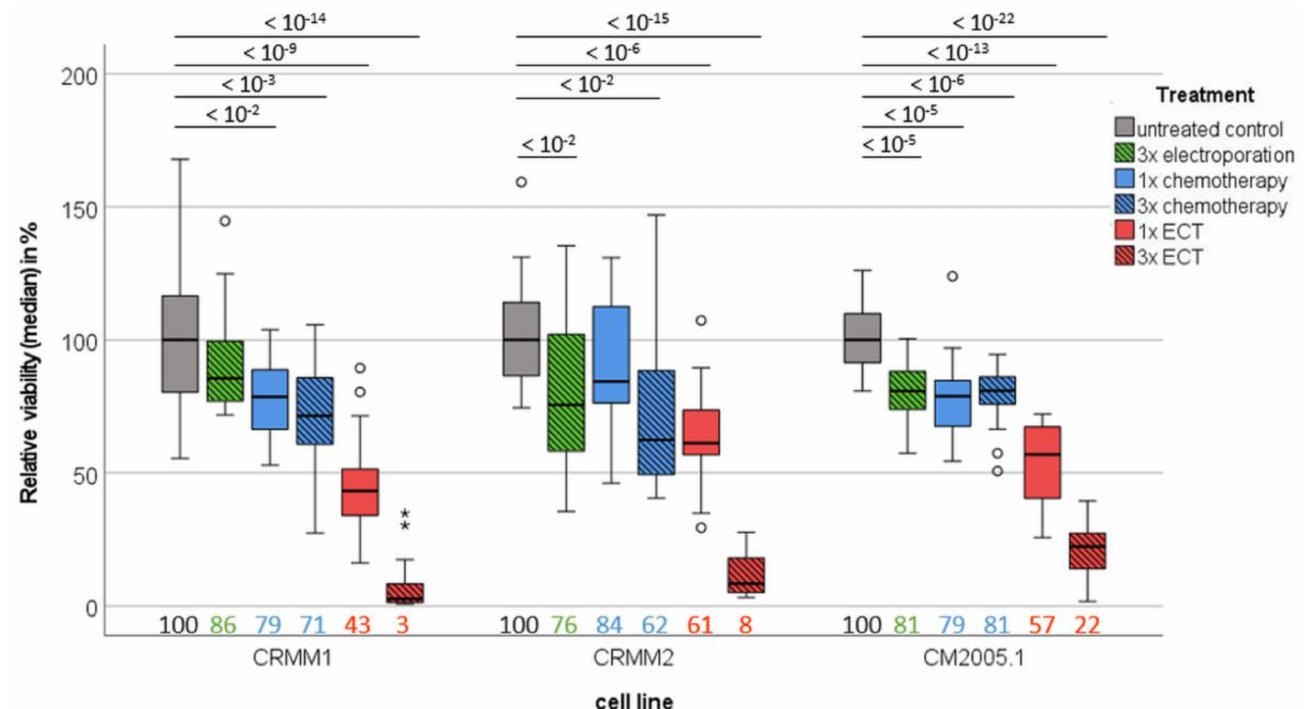
Figure 3. Comparison of the viability of different conjunctival cell lines on day 7 after different treatment options. Boxplot of the relative viability of different treatment options compared to untreated controls. Median values are listed on the bottom side of the boxplot. Statistical differences are stated above using p -Values. Abbreviations: ECT =